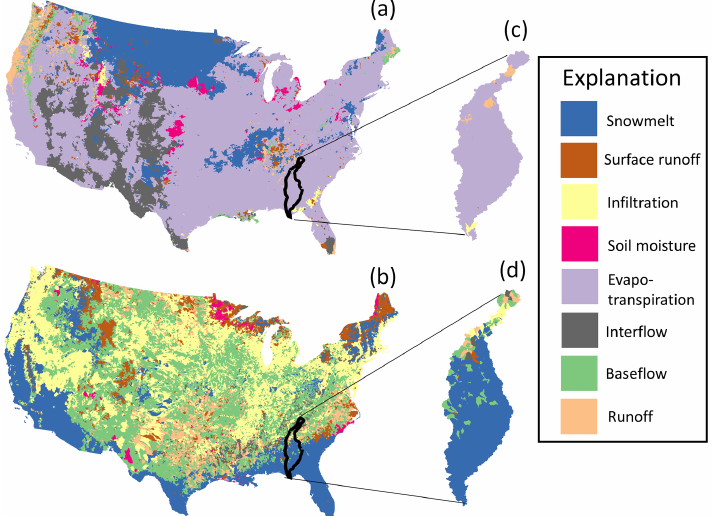
Figure 5. Precipitation–Runoff Modeling System parameter sensitivity organized by process ranked for each hydrologic response unit for the entire conterminous US – maps (a) and (b) – and for the Apalachicola–Chattahoochee–Flint River Basin – maps (c) and (d) . The maps on the top (a, c) show the most dominant process, while the maps on the bottom (b, d) show the most inferior